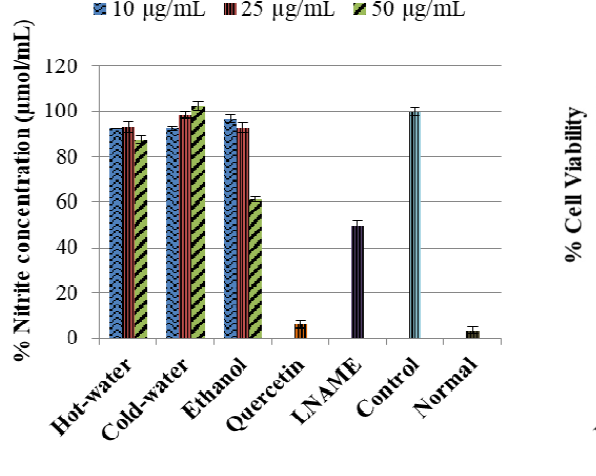
Figure 2. Inhibitory effects of P. natalensis extracts on LPS-induced PGE 2 production on RAW 264.7 macrophages treated with different concentrations (10, 25 and 50 µg/mL) and positive controls; quercetin (50 µg/mL) and LNAME (100 µM) over 24 h. 2.3.3. Effects of P. Natalensis Extracts on Cytokine Production The LPS-induced control cells increased the TNF- α non-significantly while IL1 β ( p < 0.001) and IL10 ( p < 0.001) were significantly increased in comparison to the normal cells (Figure 3). Moreover, the three extracts significantly decreased the IL1 β production very closed to LNAME. The ethanol extract significantly increased the IL10 production with 50 µg/mL ( p < 0.001) same as LNAME ( p < 0.001) in comparison to the control, while the hot-water and cold-water extracts decreased it in a dose-dependent response but were still higher than normal non-induced cells, Figure 4.